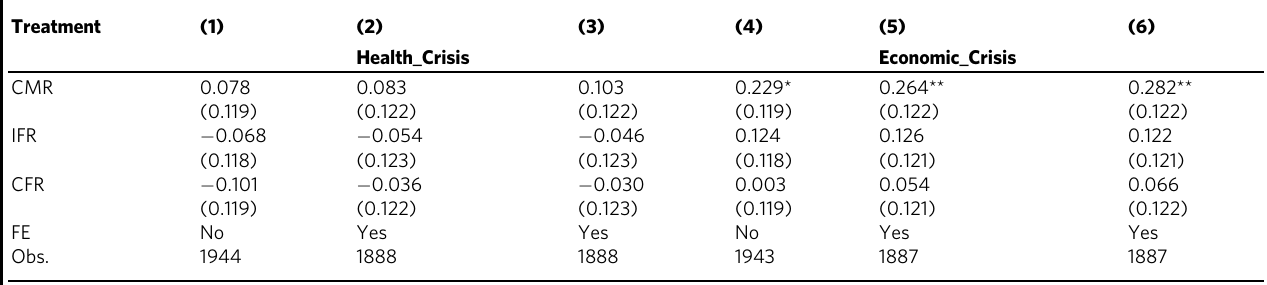
Table 4 COVID-19 mortality rates and health and economic worry.